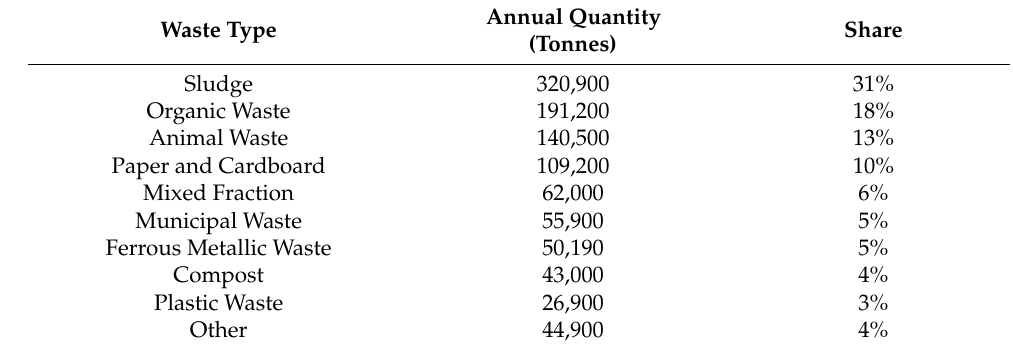
Table 2. Cypriot participants waste type profile.